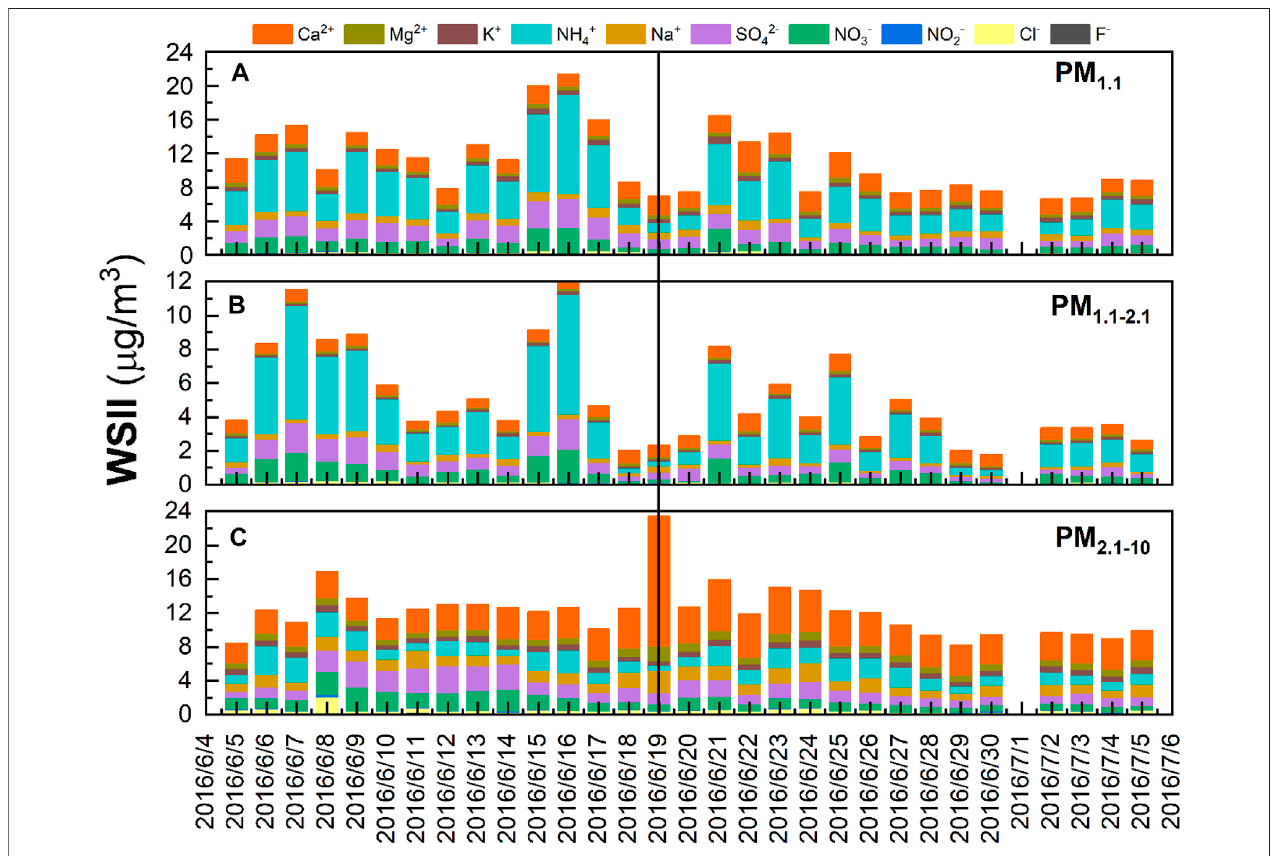
FIGURE 4 | Time series of major inorganic ions in (A) PM 1.1 , (B) PM 1.1-2.1 , (C) PM 2.1-10 during the sampling period.